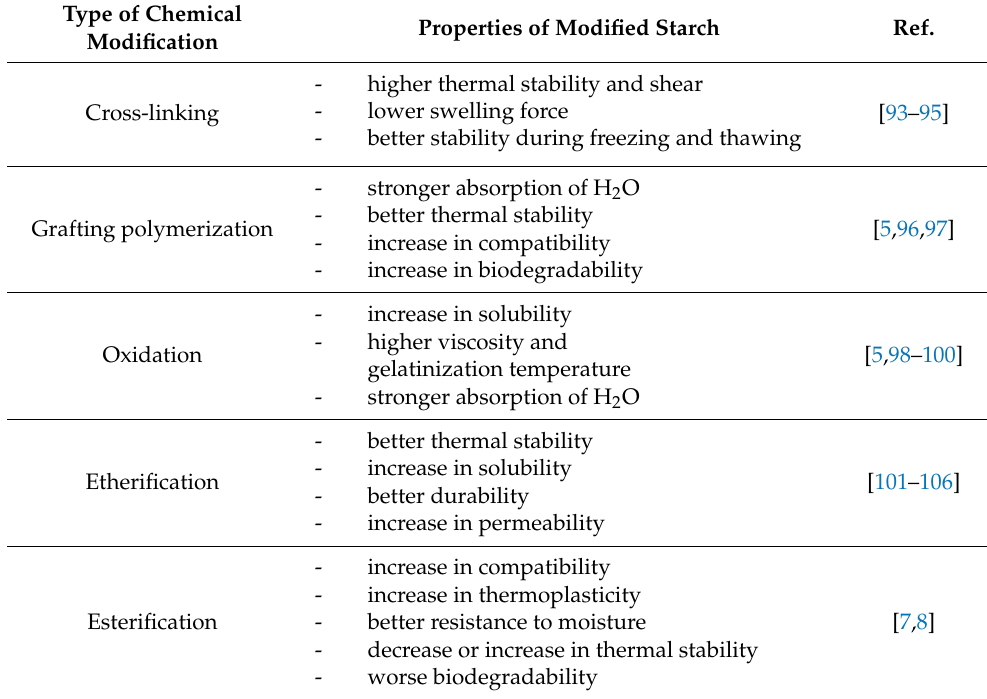
Table 1. Selected chemical modifications and changes in starch properties. Type of Chemical Properties of Modified Starch Modification